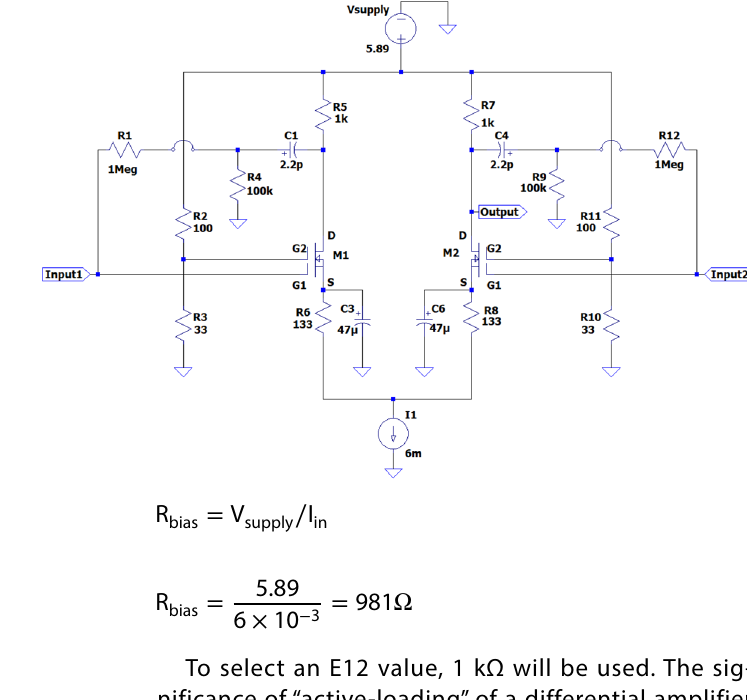
Fig. 8 Schematic of differen- tial amplifier showing chosen component values